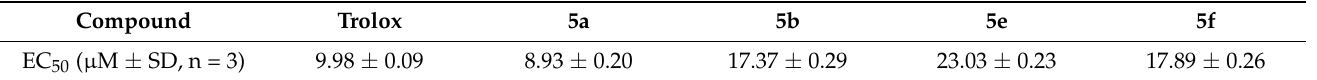
Table 1. Antioxidant activities of compounds 5a , 5b , 5e , and 5f in the ABTS assay. Compound